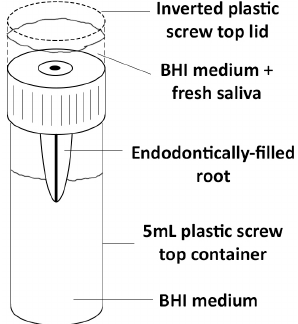
Figure 1. Schematic diagram of the experimental model.